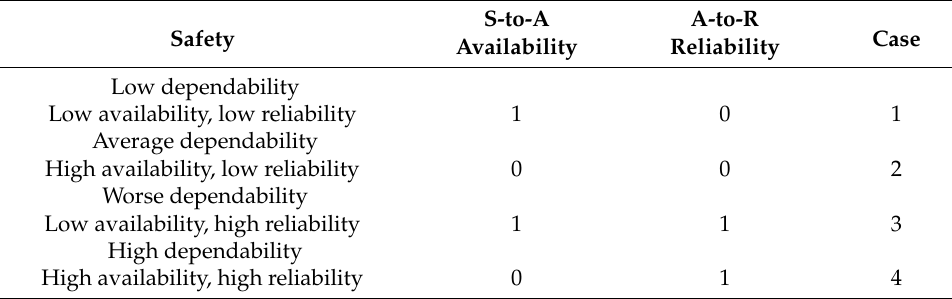
Table 1. Safety perspective to CPS